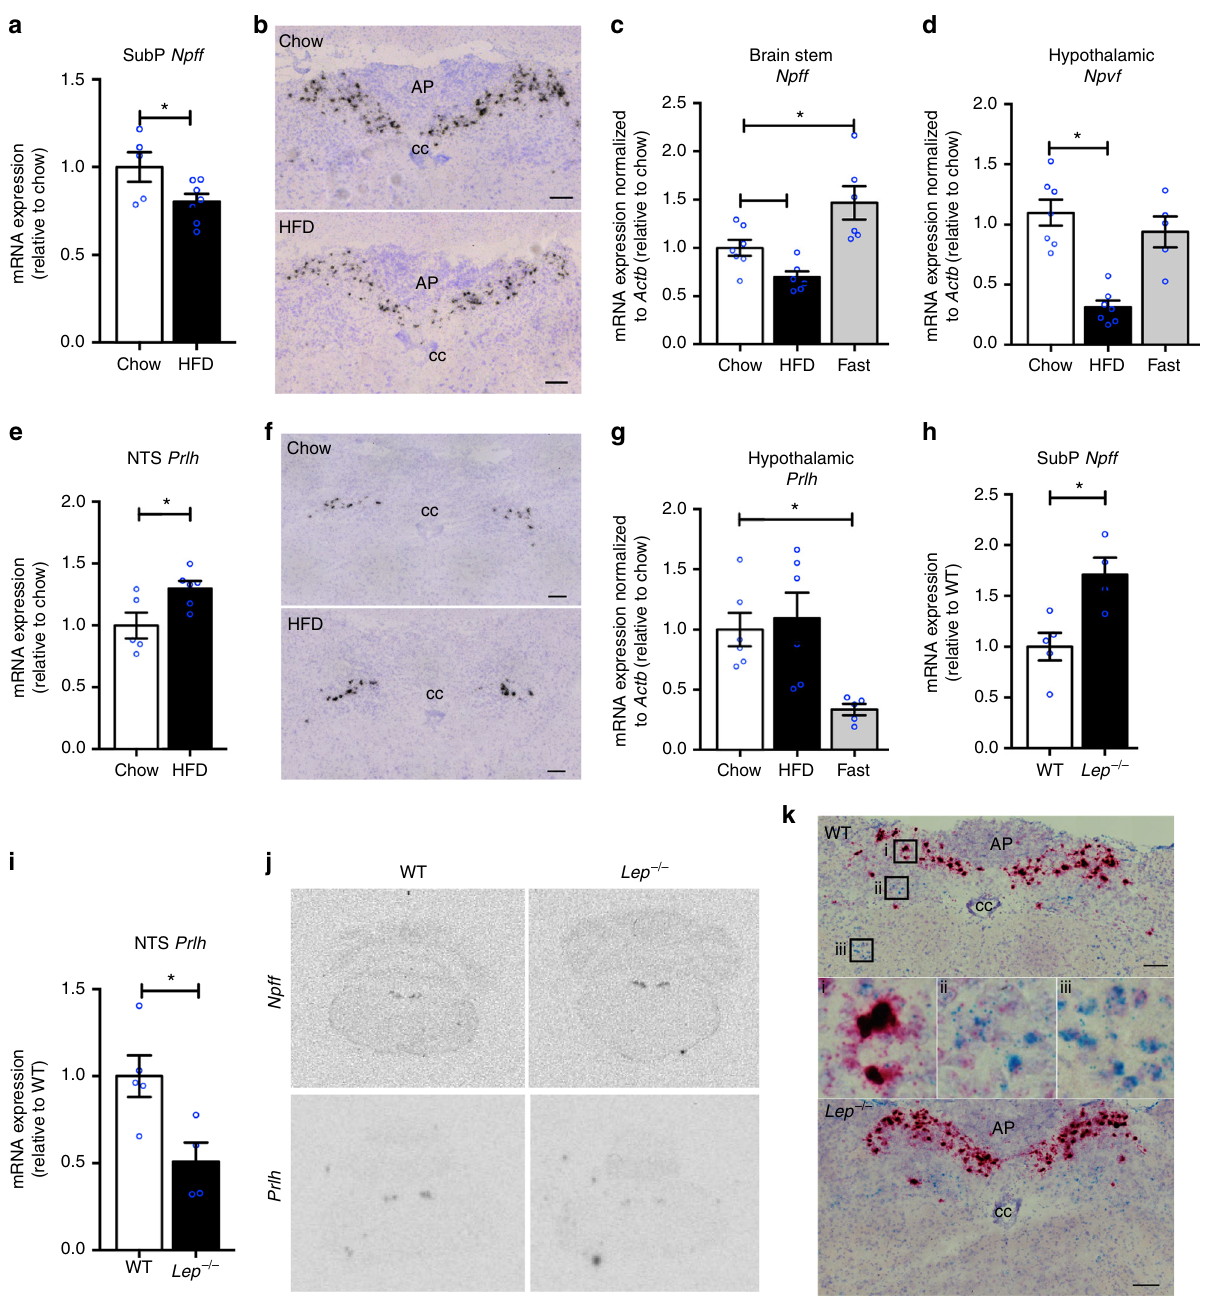
Fig. 1 Expression of RFamide peptides in mouse brain under different nutrient status. a Expression of Npff mRNA in the subpostrema area (SubP) determined by in situ hybridization (ISH) under chow ( n = 5) or HFD ( n = 7) conditions. b Representative images of a . Scale bar = 100 µ m. c Hindbrain expression of Npff determined by qPCR under chow ( n = 7), HFD ( n = 6), or 24 h fasting ( n = 6) conditions. d Hypothalamic expression of Npvf determined by qPCR under chow ( n = 7), HFD ( n = 7), or 24 h fasting ( n = 5) conditions. e Expression of PrRP ( Prlh ) in the nucleus tractus solitaries (NTS) determined by ISH under chow ( n = 5) or HFD ( n = 6) conditions. f Representative images of e . Scale bar = 100 µ m. g Hypothalamic expression of PrRP ( Prlh ) determined by qPCR under chow ( n = 6), HFD ( n = 6), or 24 h fasting ( n = 5) conditions. h Expression of Npff in the SubP determined by ISH in wild-type (WT) ( n = 5) and Lep − / − ( n = 4) mice. i Expression of PrRP ( Prlh ) in the NTS determined by ISH in WT ( n = 5) and Lep − / − ( n = 4) mice. j Representative ISH autoradiography images for h and i . k Images of dual labelling for Lepr (blue) and Npff (red) in WT and Lep − / − brains determined by RNAscope; (i) enlarged picture at SubP, (ii and iii) enlarged pictures at NTS. Data are mean ± SEM. ∗ p < 0.05 as indicated by bar determined by one-way ANOVA